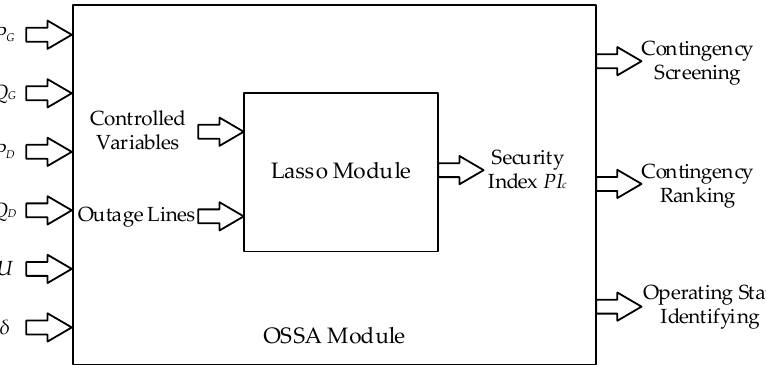
Figure 2. Overall structure of the online static security assessment method.